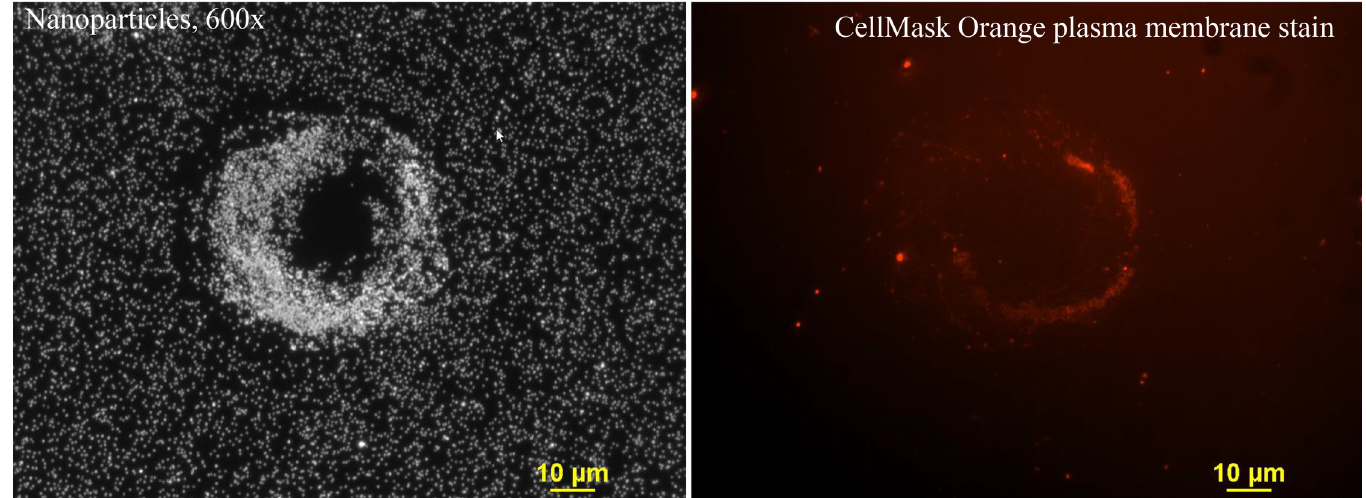
Fig 4. A single ring structure was obtained with darkfield optics using a 60-x plan Fluor objective with an iris diaphragm (NA 0.55–0.90). Panel A. A darkfield image of silver nanoparticles showing a concentrated ring structure. Panel B. A fluorescent image of the same field as Panel A after the slide was stained with Cell Mask Orange plasma membrane stain (red). A red ring of membrane proteins was observed corresponding to the circular formation of nanoparticles in Panel A. This suggests that cell membrane components remained on the slide after completion of mitosis. These residual materials were part of the cell membrane that preferentially attracted and/or bound silver nanoparticles that were deposited on the slide surface. The diameter of the circle was 53 μ m, the inside circle was 27 μ m, and the fluorescent ring was 37 μ m. Magnification 600x., AgNP citrate 3ug/ml.